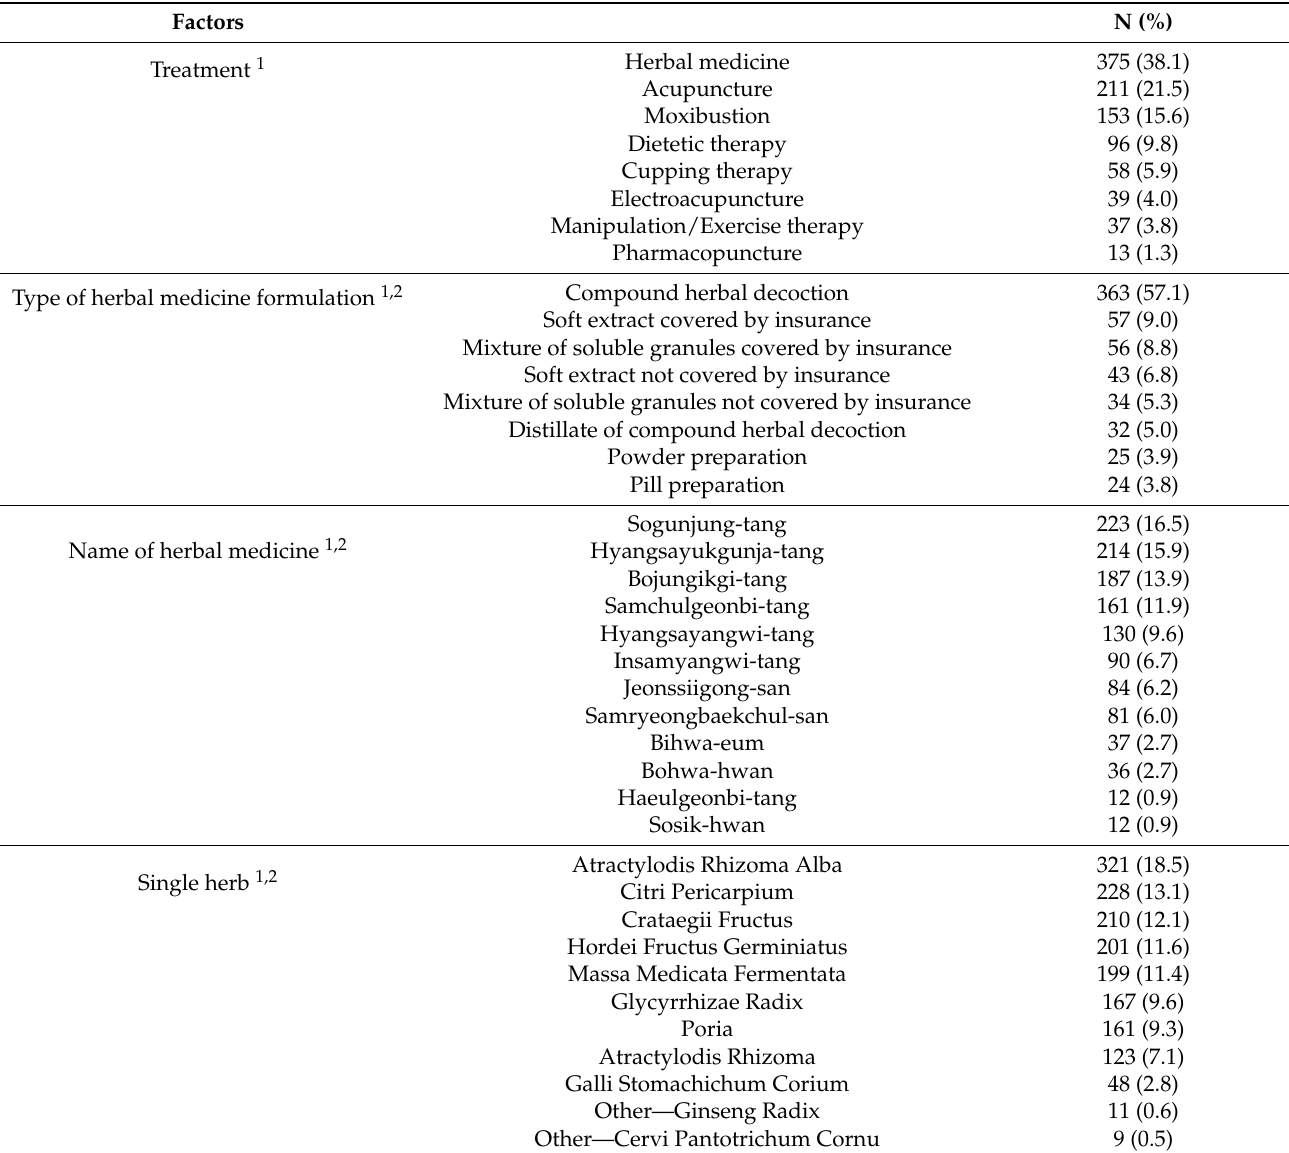
Table 3. Frequently used Korean medicine treatments for children with anorexia (N =